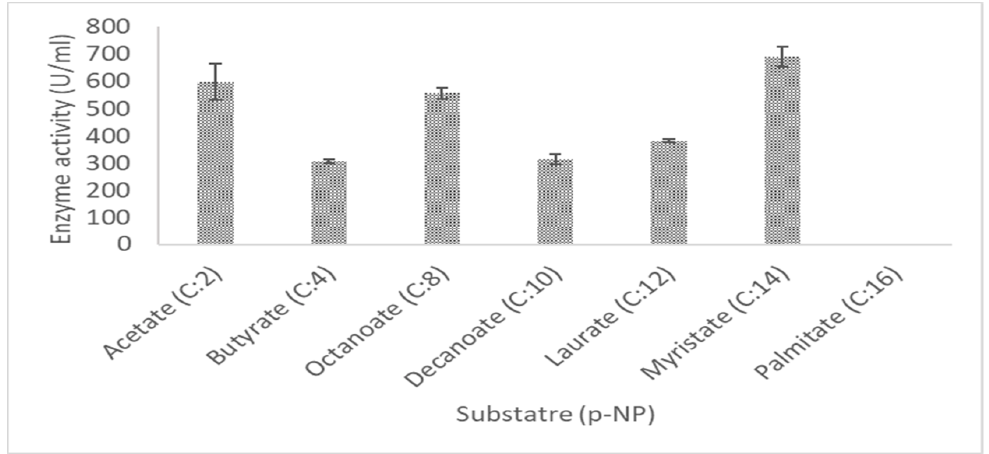
Figure 10. Substrate specificity of purified LIP2 lipase towards p NP esters. The lipase assay was tested by using various p NP esters as a substrate at 30 °C in Tris-HCL (pH 9.0).